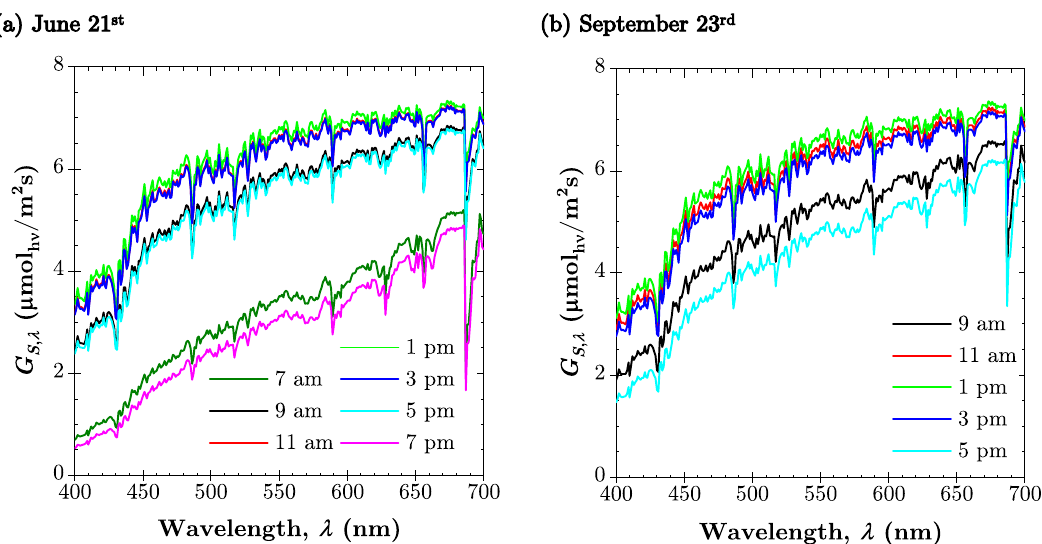
Figure 3. Incident collimated solar irradiance G S , λ over the PAR region at different times of day simulated on ( a ) 21 June and ( b ) 23 September in Los Angeles, CA. Table 1. Solar zenith θ z and azimuth γ s angles (in degrees) for the different times simulated on